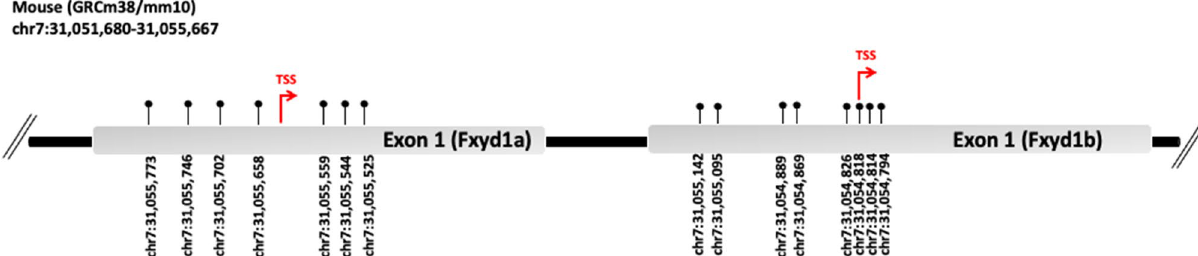
Figure 1. Schematic representation of Fxyd1 gene. Promoters of Fxyd1a and Fxyd1b isoforms are shown. The chromosomal coordinates of the entire Fxyd1 are reported. The two alternative Transcriptional Start Sites are indicated with red arrows. Position of each analyzed CpG is indicated with the respective genomic